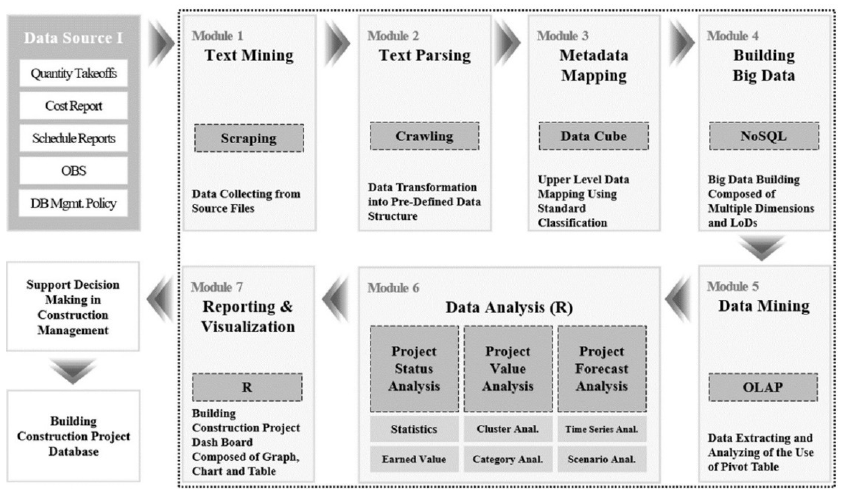
Figure 5. Big Data System Architecture for Cost-Schedule Integration Consisting of Seven Modules.